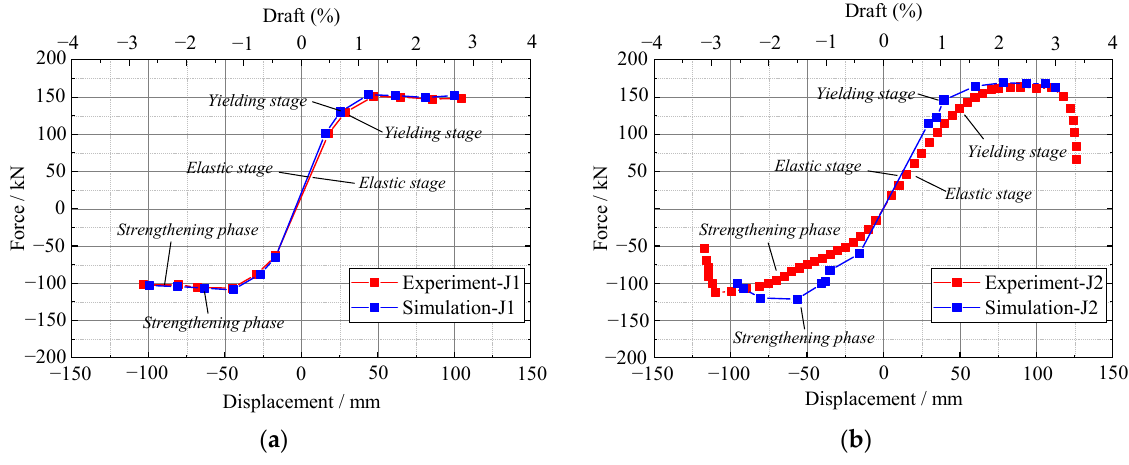
Figure 24. Comparison of experimental simulated skeleton curves: ( a ) J1, ( b ) J2.